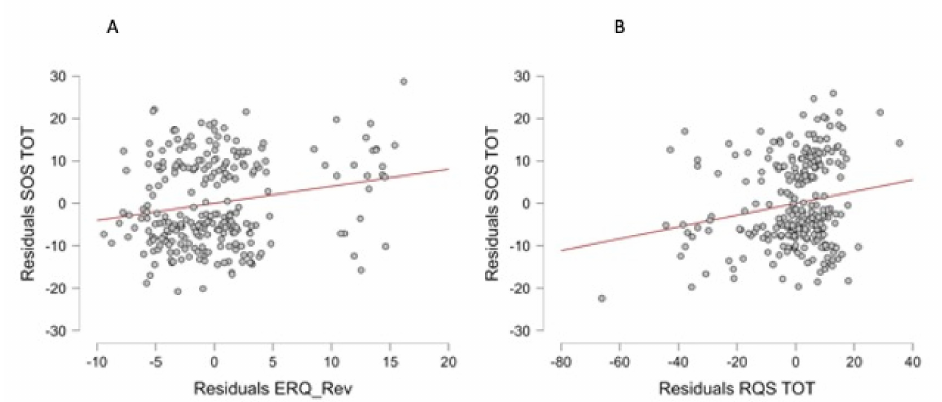
Figure 1. The relationship between the average SOS and ( A ) the ERQ_Rev and ( B ) the RQS TOT. Each data point represents one participant. The regression line is indicated by the intersected red line.